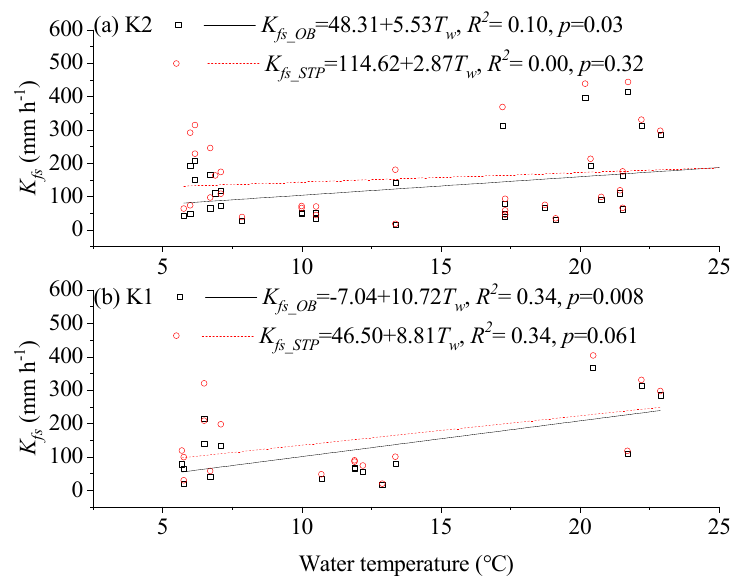
Figure 7. The relationship between K fs and infiltrating water temperature at ( a ) K2 and ( b ) K1 sites. K fs : field-saturated hydraulic conductivity; K fs_OB : observed K fs ; K fs_STP : K fs that was viscosity-corrected to the standard temperature of 25 °C; T w : water temperature.